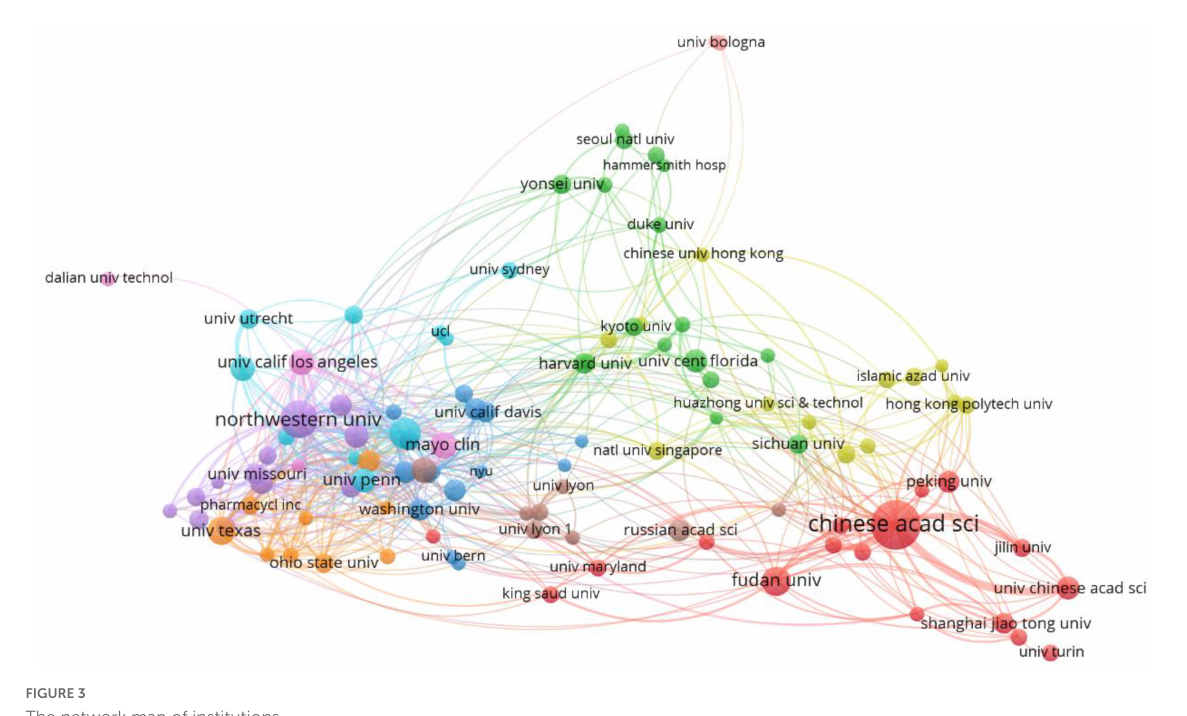
FIGURE3 The network map of